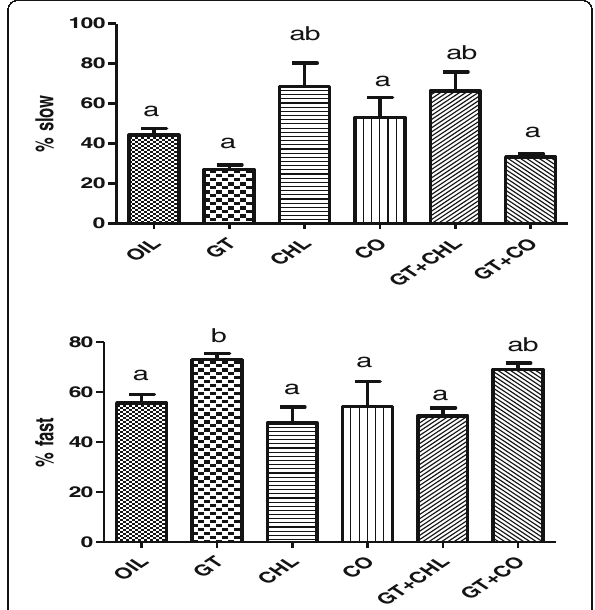
Fig. 3 Sperm progressive assessment (%) in Wistar rats treated with mineral oil (OIL), green tea (GT), chlorpyrifos (CHL), extract of clove oil (CO), green tea and chlorpyrifos (GT+CHL), and green tea and extract of clove oil